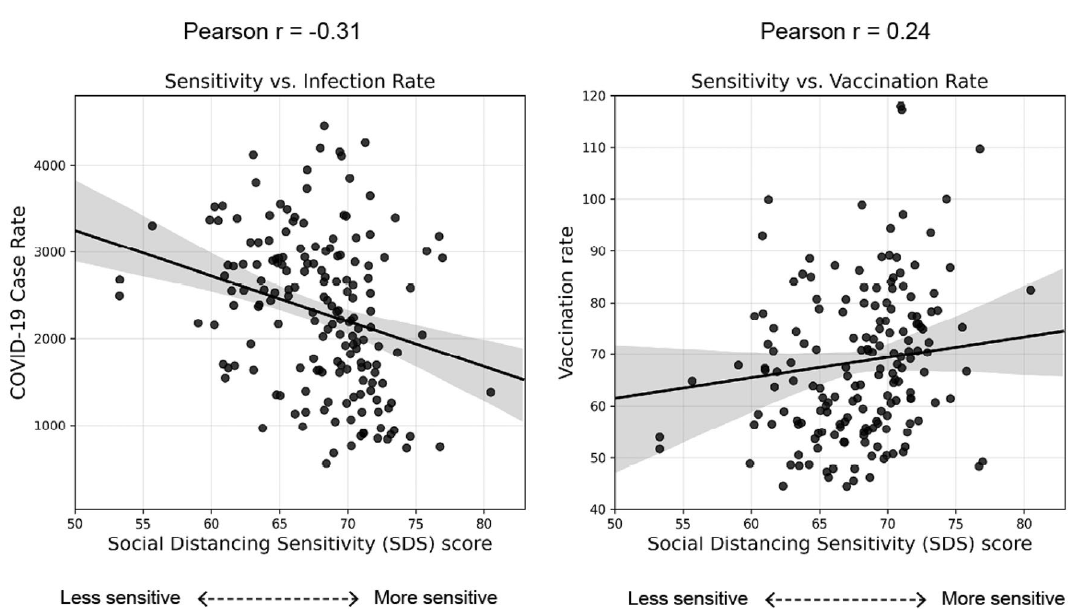
Figure 6. Relationship between neighborhood sensitivity and public health measures. Left: neighborhood sensitivity versus cumulative COVID-19 case rate as of July 2, 2020. Right: neighborhood sensitivity versus cumulative COVID-19 vaccination rate as of July 30,